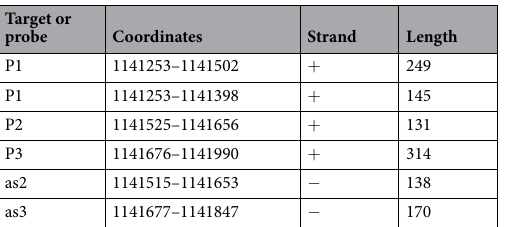
Table 4. RACE-mapping characterization of sRNAs transcribed from